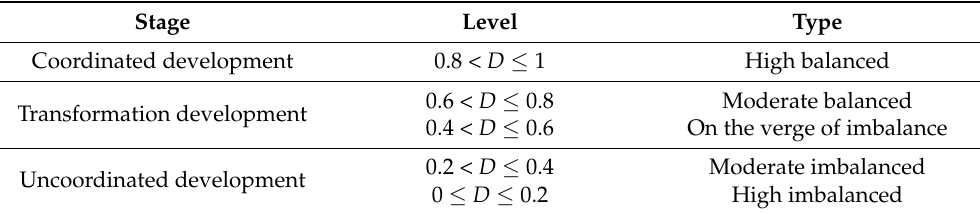
Table 6. The standards and types of the coupling coordination degree. Stage Level Type Coordinated development 0.8 < D ≤ 1 High balanced 0.6 < D ≤ 0.8 Moderate balanced Transformation development 0.4 < D ≤ 0.6 On the verge of imbalance 0.2 < D ≤ 0.4 Moderate imbalanced Uncoordinated development 0 ≤ D ≤ 0.2 High